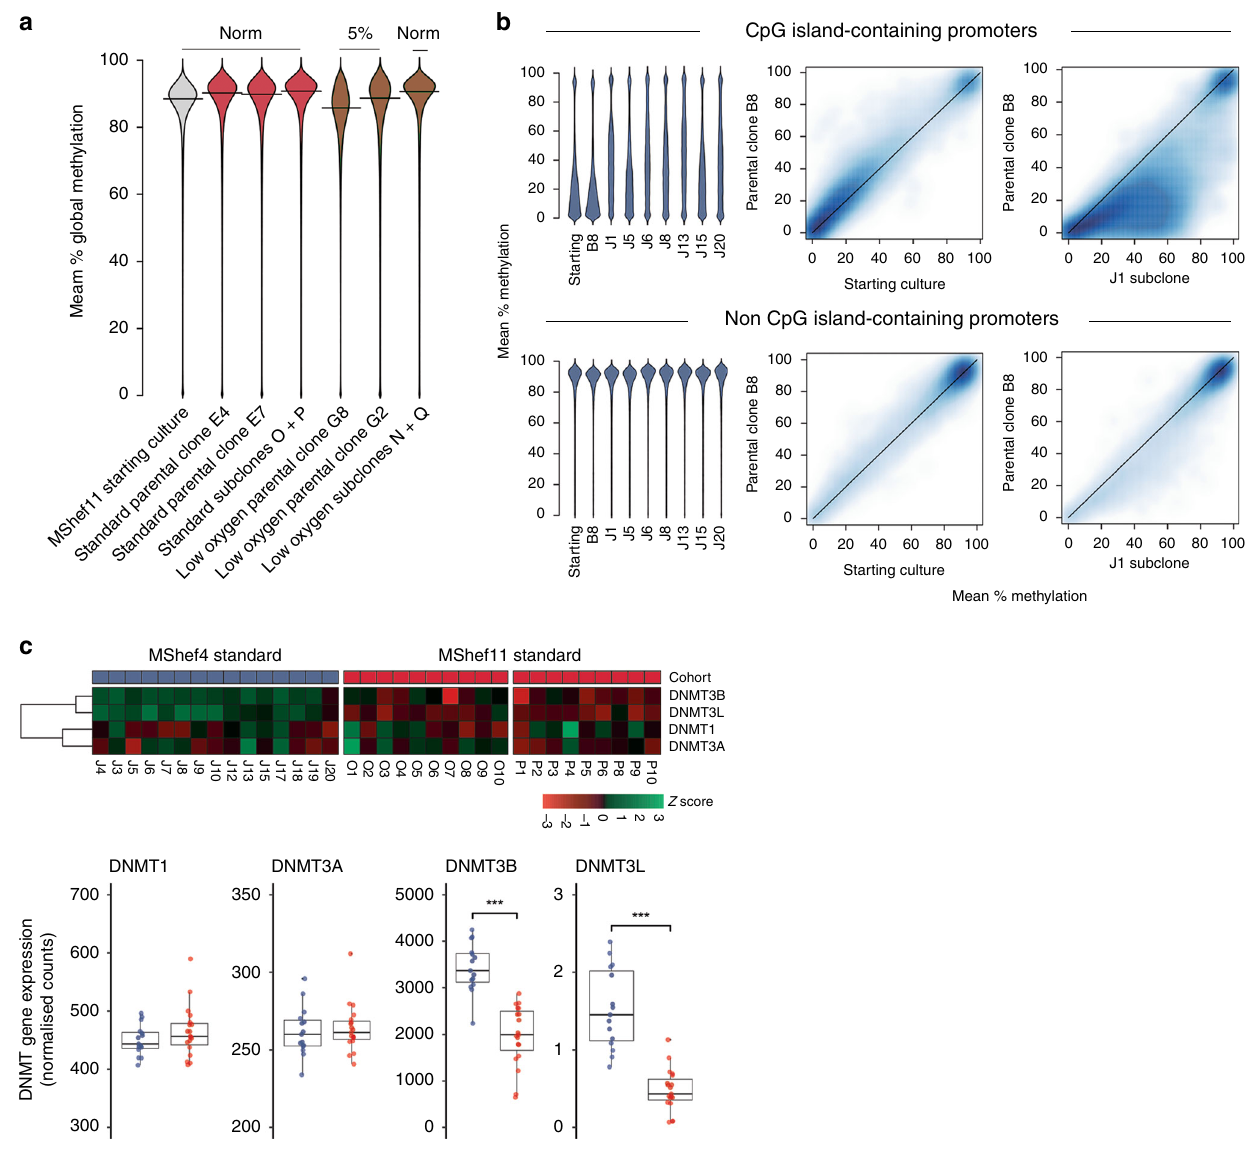
Fig. 6 Epigenetic changes. a Beanplots showing global DNA methylation levels of MShef11 starting cultures, parental clones grown in standard or low oxygen conditions, and the subclones derived from those conditions. Methylation was assessed over tiled probes across the genome, each containing 100 CpGs. Both parental clones grown in low oxygen show a small decrease in methylation, particularly clone G8. This decrease in methylation was reversible, as subclones derived from low oxygen revert to normal methylation levels following expansion in standard conditions. Source data are provided in Supplementary Data 6. b DNA methylation of promoters in MShef4 subclones ( N = 20). Promoter regions were de fi ned as regions surrounding transcription start sites, with 1500 kb upstream and 500 kb downstream context. Beanplots (left panels) show DNA methylation levels of promoters with and without CpG islands, in a randomly selected subset of MShef4 J subclones. For both classes of promoter, the starting culture and the parental clone, B8, derived from that starting culture had comparable methylation levels, whereas each J subclone showed hypermethylation of a subset of CpG island- containing promoters compared to its parental clone, B8. Density scatter plots (right panels) show the distribution of promoter methylation levels between the MShef4 starting culture and its derived parental clone, B8, and between the parental clone B8 and an example subclone, J1. The density scatter plots show comparable levels of non-CpG island-promoter methylation between starting culture material and parental clone B8, but hypermethylation of CpG island-containing promoters in subclone J1 compared to parental clone B8. Source data are provided in Supplementary Data 9 – 12. c Top panel; heatmap showing the relative expression of de novo methyltransferase ( DNMT ) genes in MShef4 ( N = 20) and MShef11 ( N = 19) subclones from standard conditions. Lower panel; box and whisker plots showing the normalised expression counts (fragments per million reads) for DNMT genes in MShef4 and MShef11 standard subclones. Both DNMT3B and DNMT3L are more highly expressed in MShef4 subclones ( P = 7.2 − 8 and P = 2 − 8 ). Boxes represent the 25th – 75th percentiles of the data; whiskers show the min and max range of the data; horizontal lines indicate the median value. ns: P > 0.05; * P ≤ 0.05; ** P ≤ 0.01, *** P ≤ 0.001; **** P ≤ 0.0001. Source data are provided in Supplementary Data